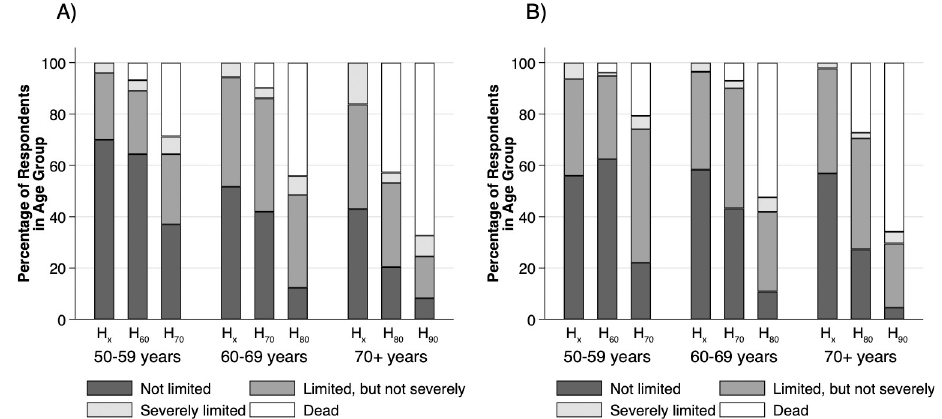
Fig 1. Current and future health expectation patterns by age group in A) men and B) women. H x : current health status as measured by the Global Activity Limitations Indicator (GALI); H 60/70/80/90 : subjectively expected health status on the GALI for ages 60/70/80/90